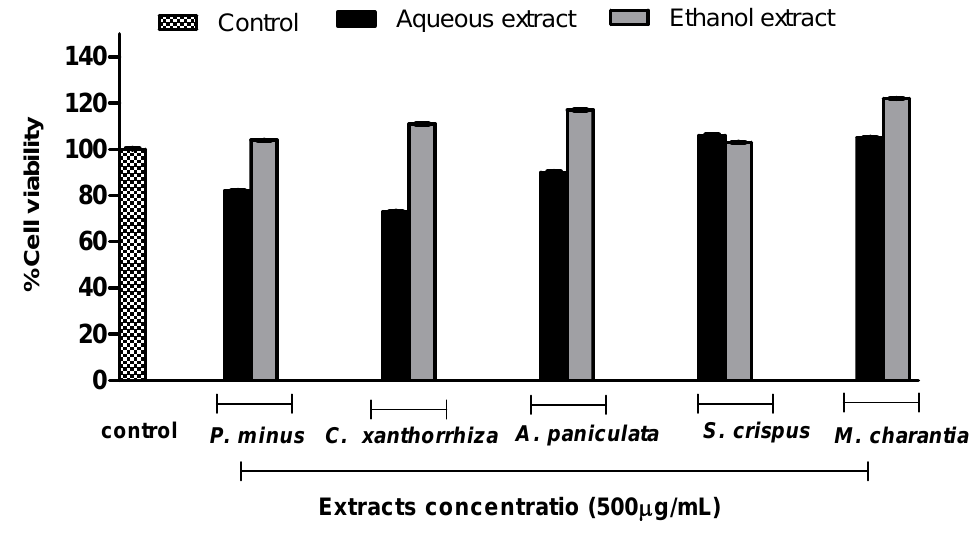
Figure 3. Cytotoxic activity of five Malaysian plants in normal lung (Hs888Lu) cell line at concentration of 500 µg/mL and 24 hr exposure